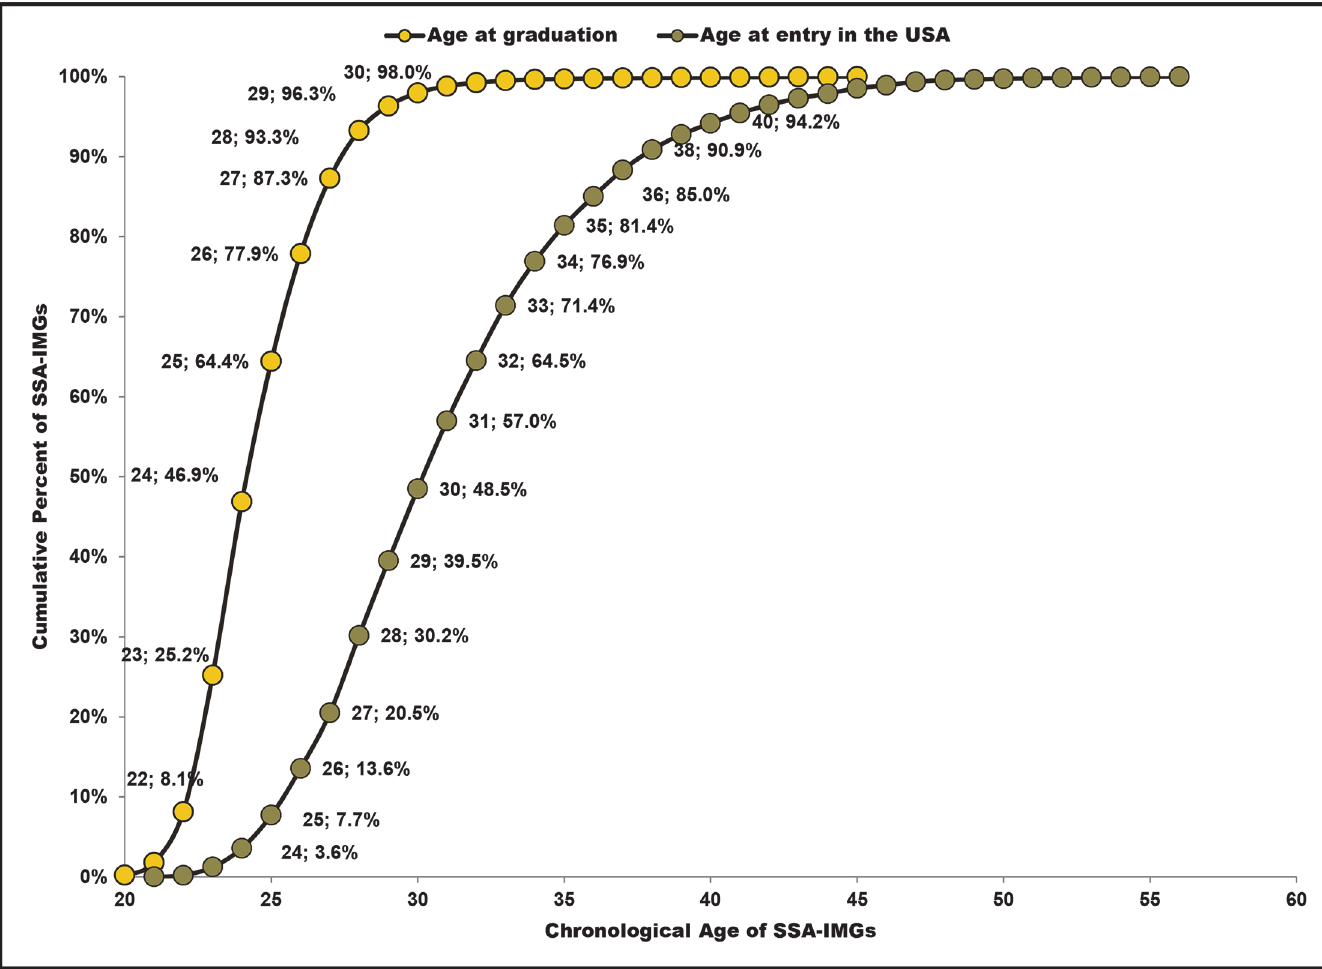
Fig 2. Cumulative distribution curves for Sub-Saharan African international medical graduates ’ (SSA-IMGs) ages at time of graduation and at time of entry into the United States. Data source: From the 2011 American Medical Association Physician Masterfile data in Tankwanchi [37].